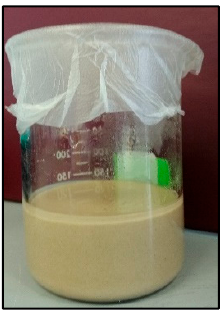
Figure 5. Picture of batch experiment to test for adsorption.